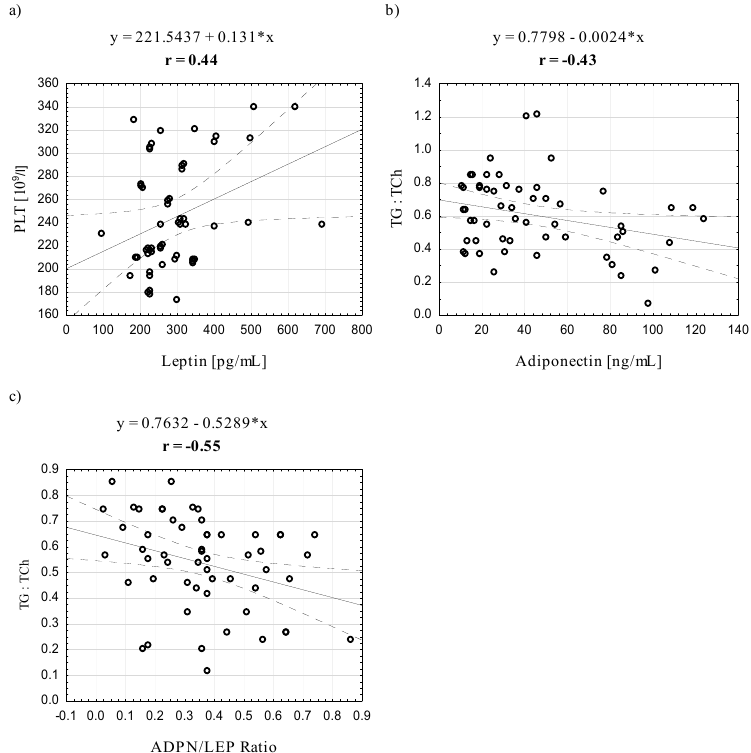
Figure 4. Scatter plots for the correlation ( p < 0.05) between leptin, adiponectin and the ADPN/LEP ratio and platelet counts and the TG:TCh ratio in the group of